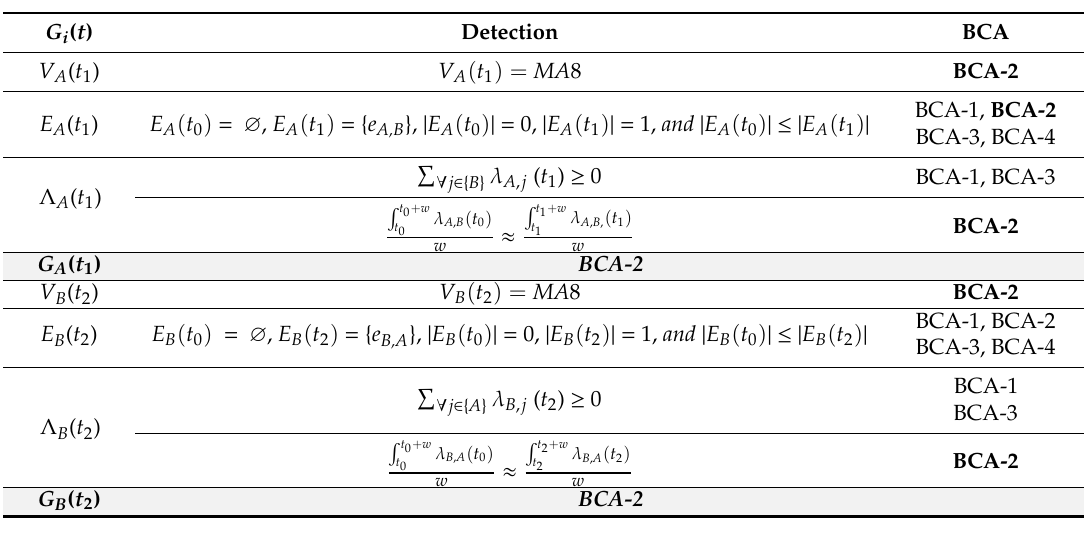
Table 7. BCA-2 detection on host A and B at t 1 and t 2 in Scenario